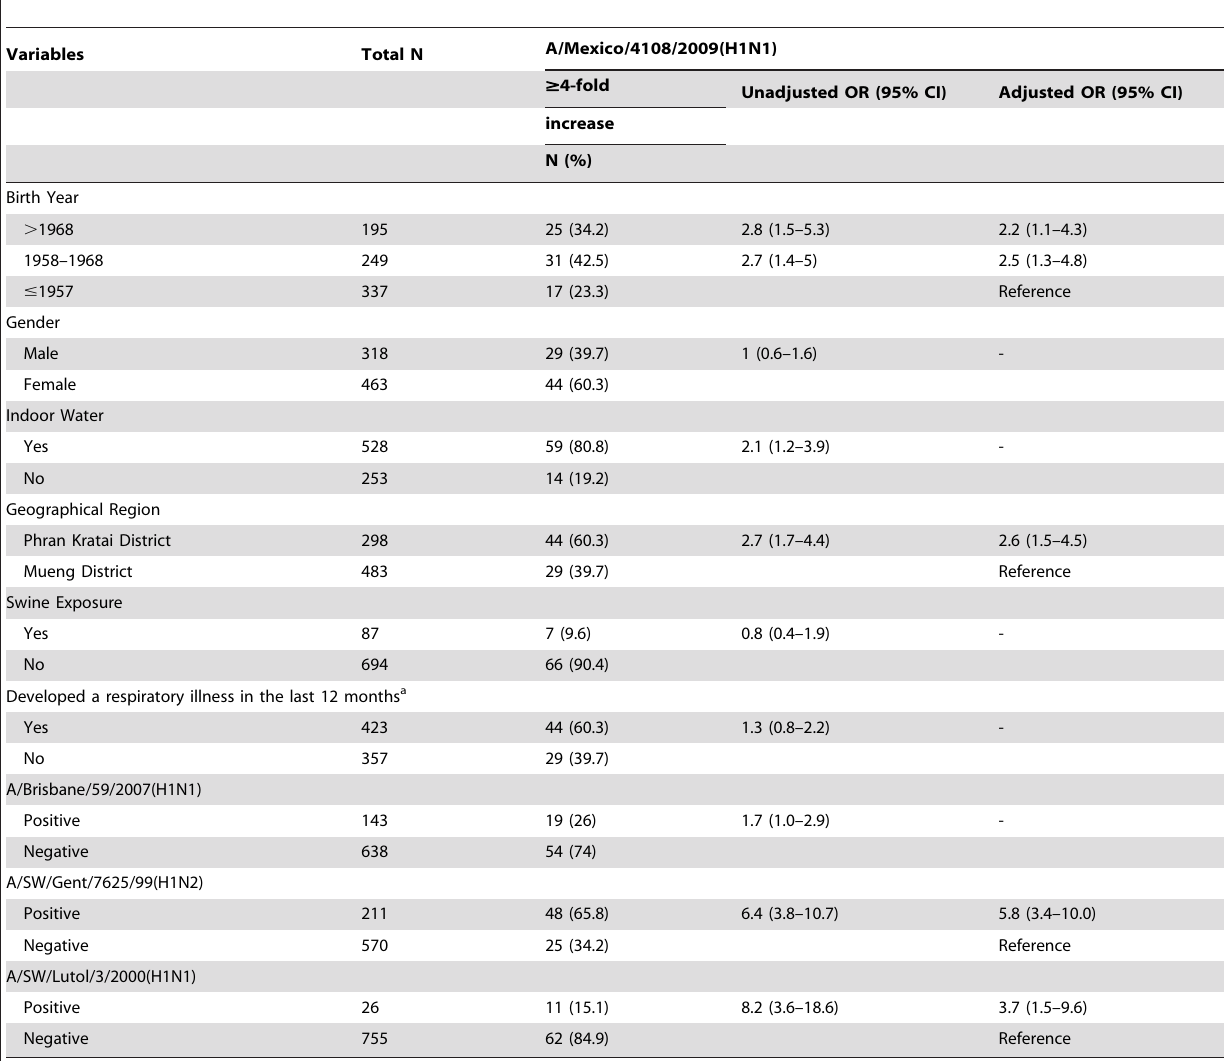
Table 2. Risk factors for $ 4-fold increase in hemagglutination inhibition (HI) titer against A/Mexico/4108/2009(H1N1) from 2009 to 2010 among cohort subjects, Kamphaeng Phet, Thailand; odds ratios calculated by binary logistic